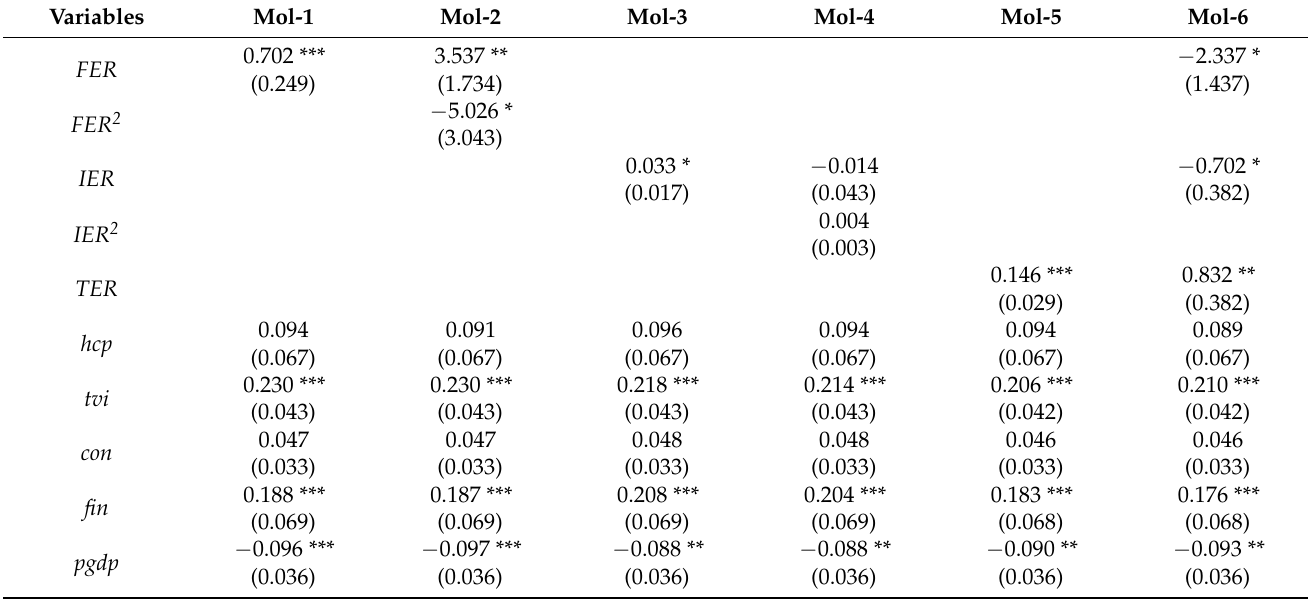
Table 4. Regression results for all